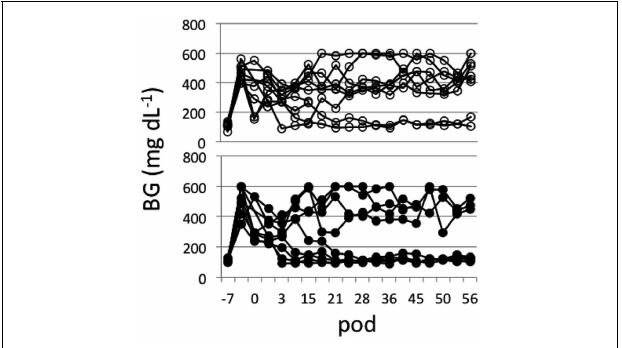
FIGURE 5 | Non-fasting blood glucose (BG) level profiles of STZ induced diabetic Lewis rats measured for up to 56 post-operative days (pod) following transplantation with islets ( ∼ 500 IEQs) from donor pancreata infused with HBSS/BSA solution containing 100 µ M